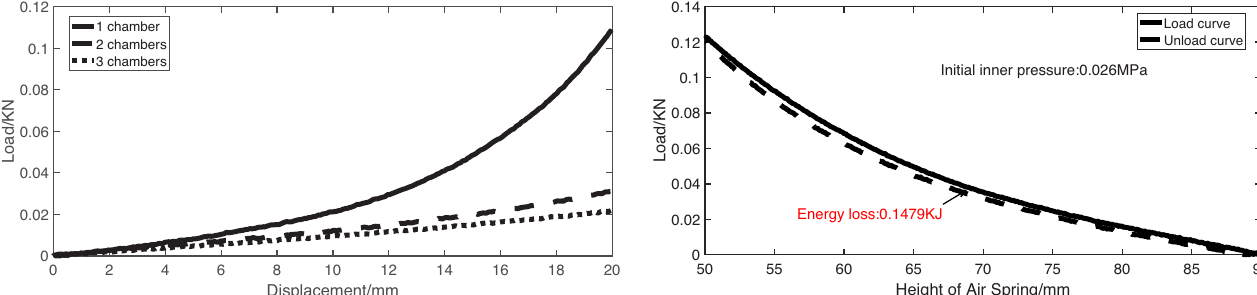
Fig. 5. Curves of force and displacement for different air spring. Fig. 6. Curves of loading and